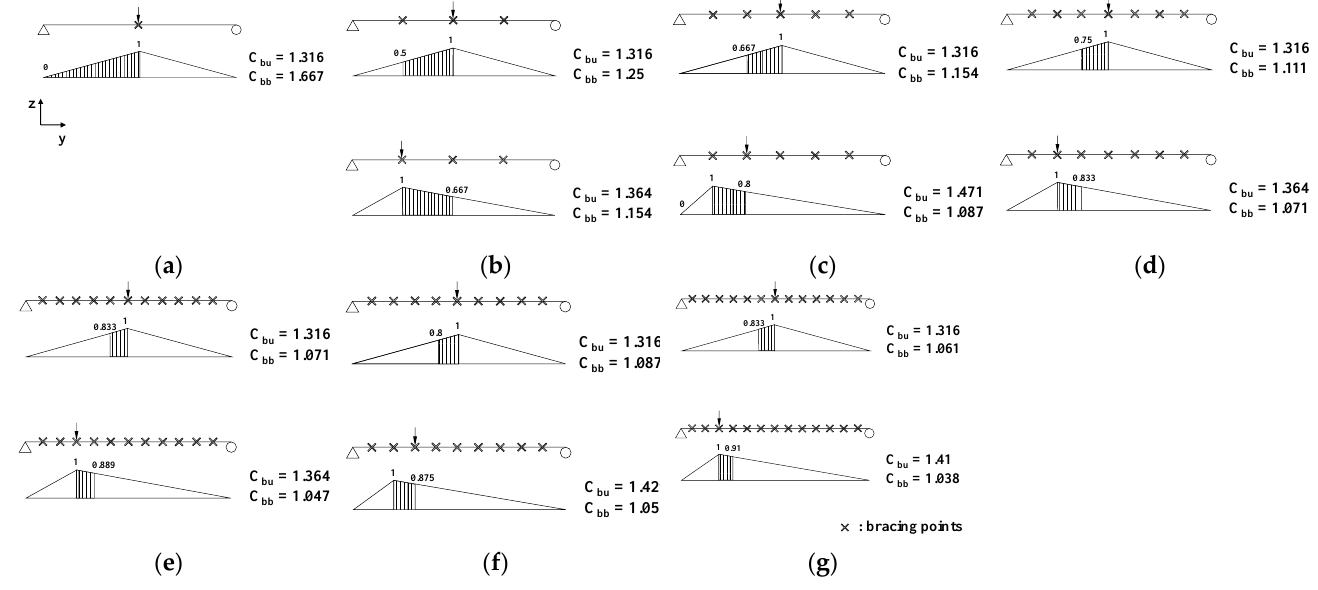
Figure 3. Applied loading conditions considering various moment gradient effects when the number of bracings is ( a ) 1; ( b ) 3; ( c ) 5; ( d ) 7; ( e ) 9; ( f ) 11; and ( g ) 13.